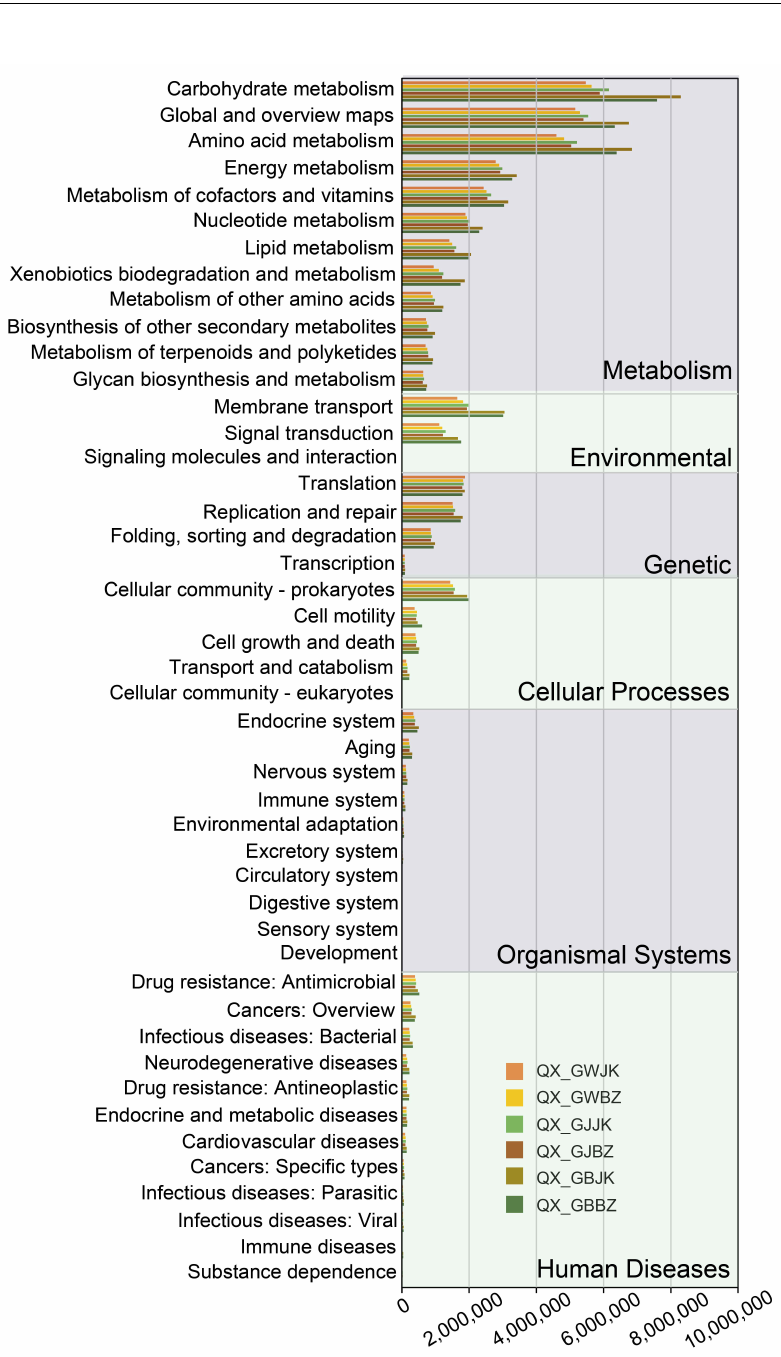
Figure 7. Functional prediction of the bacterial community. Note: QX_GBBZ denotes the rhizoplane diseased plants, QX_GBJK denotes the rhizoplane healthy plants, QX_GJBZ denotes the rhizosphere diseased plants, QX_GJJK denotes the rhizosphere healthy plants, QX_GWBZ denotes the root zone diseased plants, and QX_GWJK denotes the root zone healthy plants.